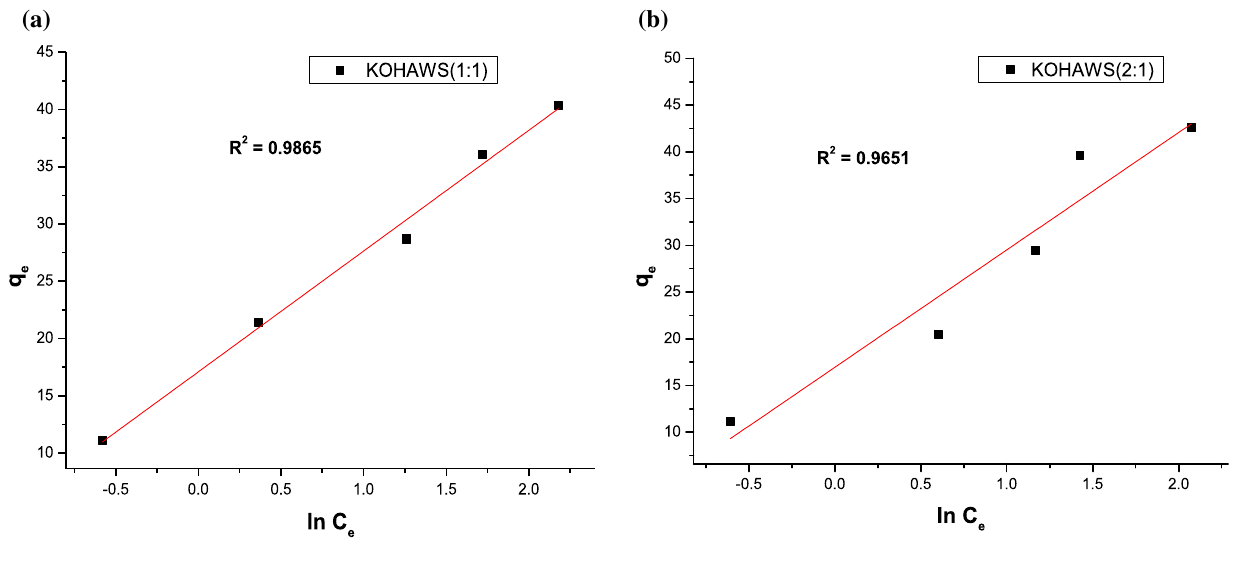
Fig. 14 Temkin isotherm for a KOHAWS1 and KOHAWS2